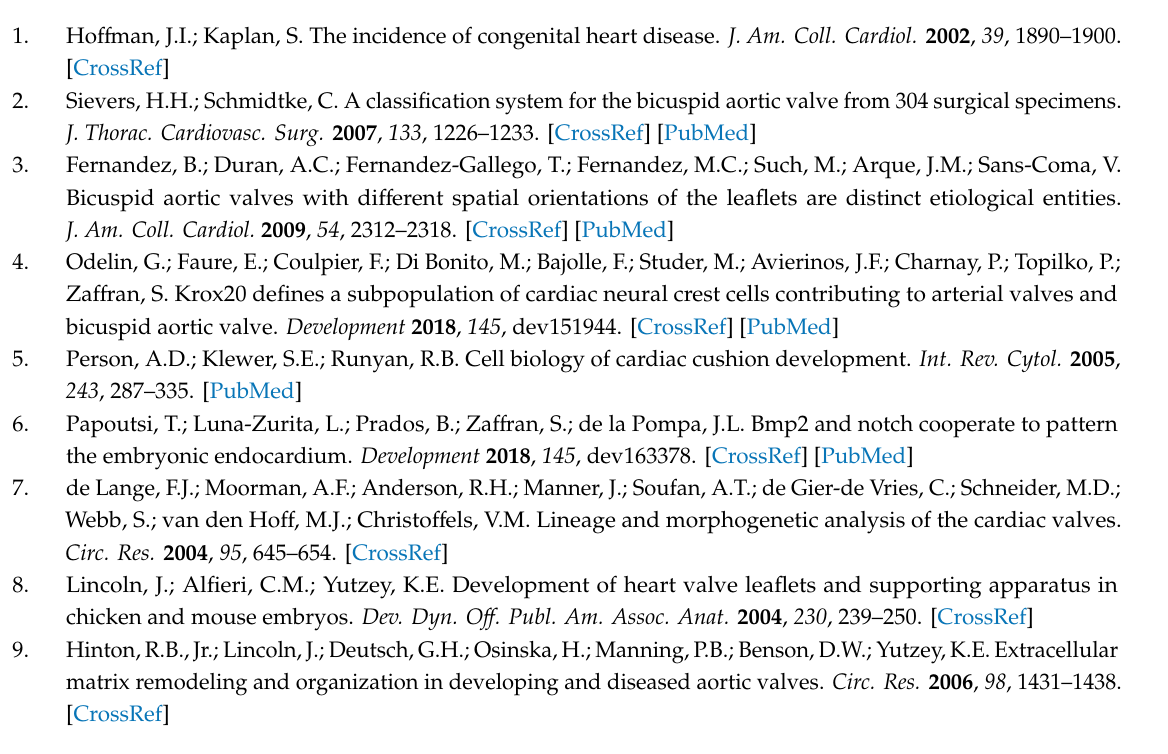
Figure S1: Pecam expression showing integrity of the endothelium in all genotypes, Figure S2: Nos3 expression in Tie2-cre;Krox20f / f and Wnt1-cre;Krox20f / f embryos at